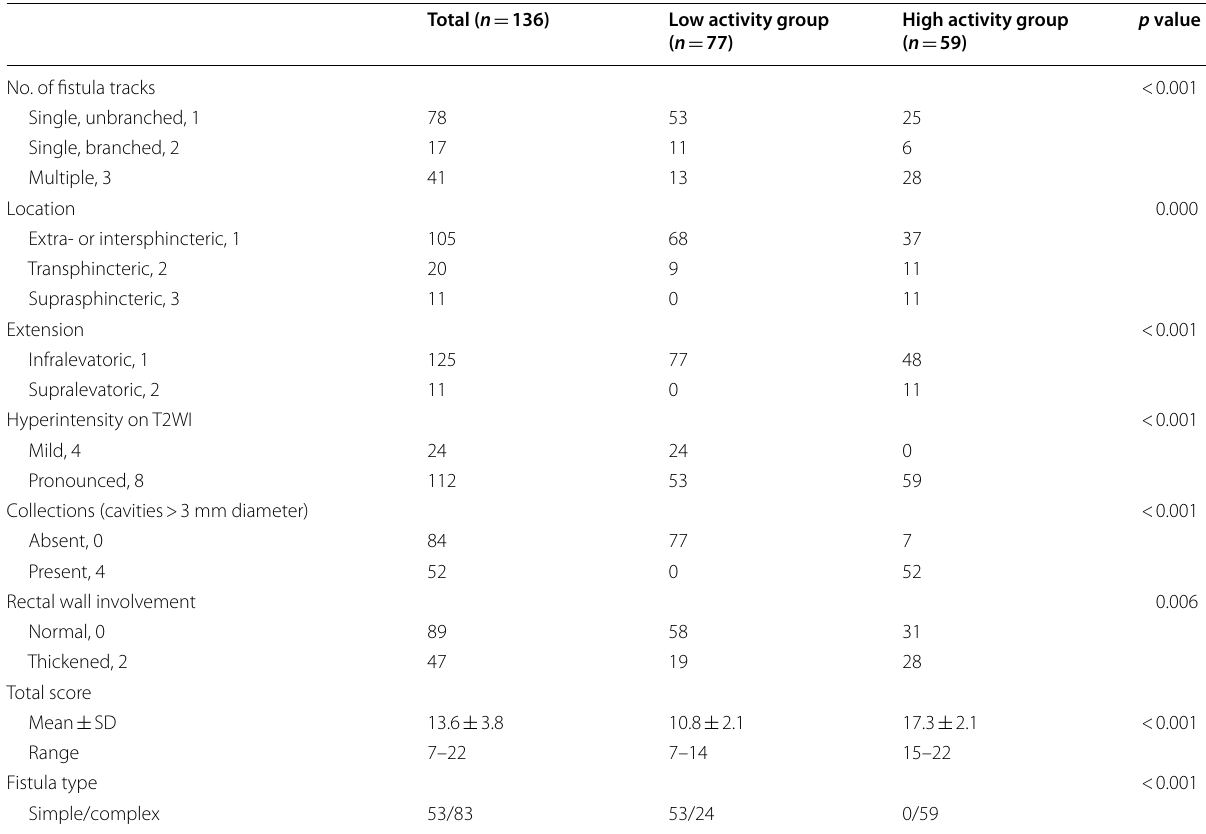
Table 2 Baseline MRI features of perianal fistula in both